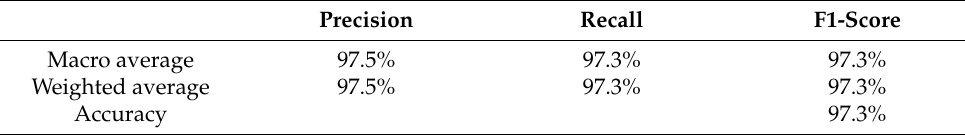
Table 5. Evaluation results of the car model classification model on the testing